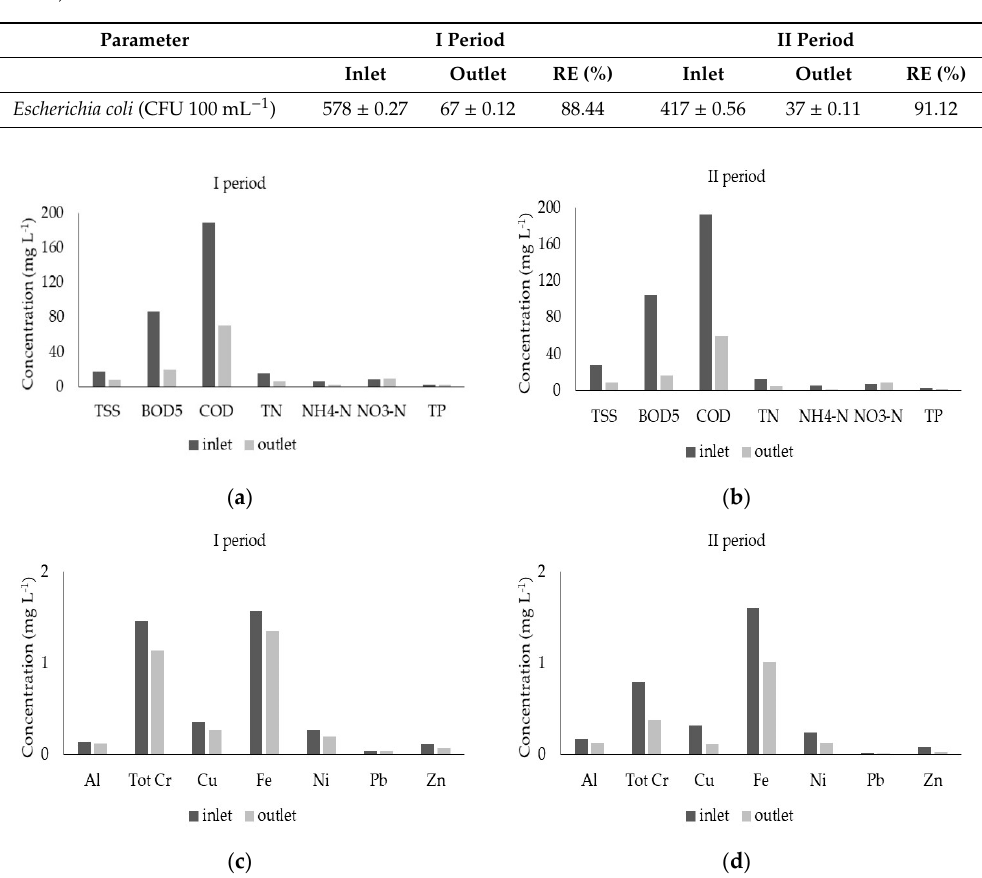
Figure 6. Average concentrations (mg L − 1 ) for chemical parameters at the VSSFs CW inlet and outlet, during first-flush stormwater treatment (I and II monitoring periods). Graphs ( a , b ) refer to organic pollutants and macronutrients, while graphs ( c , d ) refer to trace elements. At the inlet of the CW unit, pretreated FFSW pollutant concentrations were lower than prior to